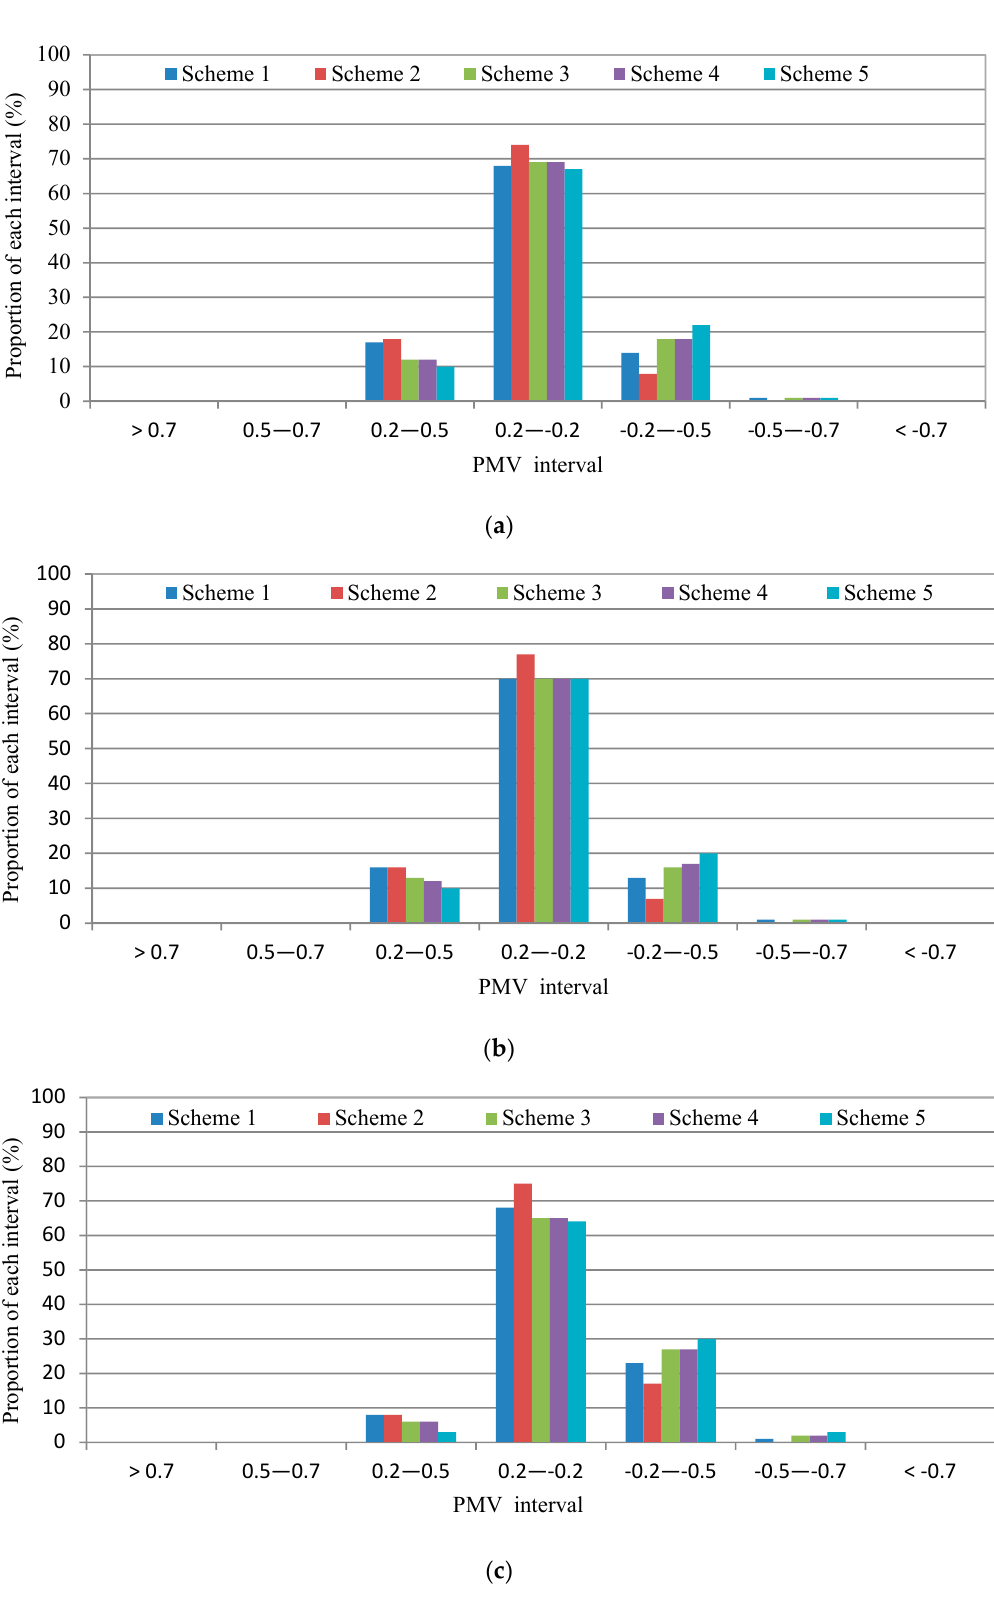
Figure 15. Proportions of time that different PMV intervals occur throughout the entire period of cooling under different distributions of time for cooling. ( a ) Top floor room; ( b ) second floor room; and ( c ) ground floor room.